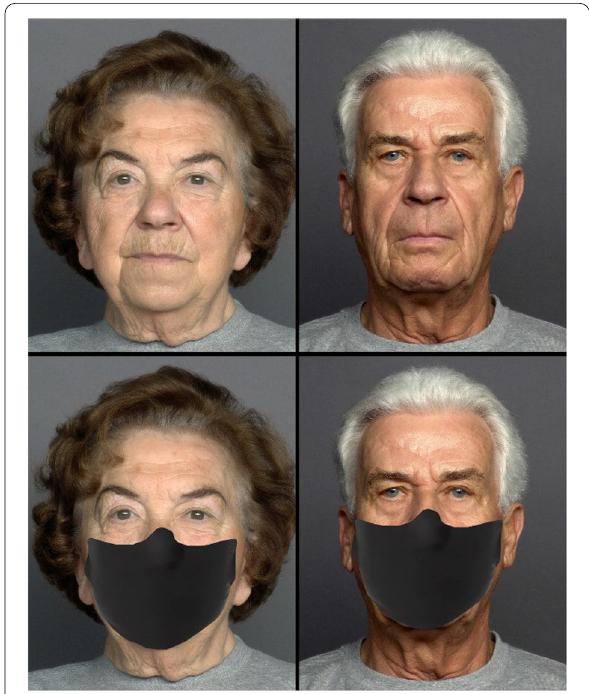
Fig. 3 Examples of old male and female faces used in Study